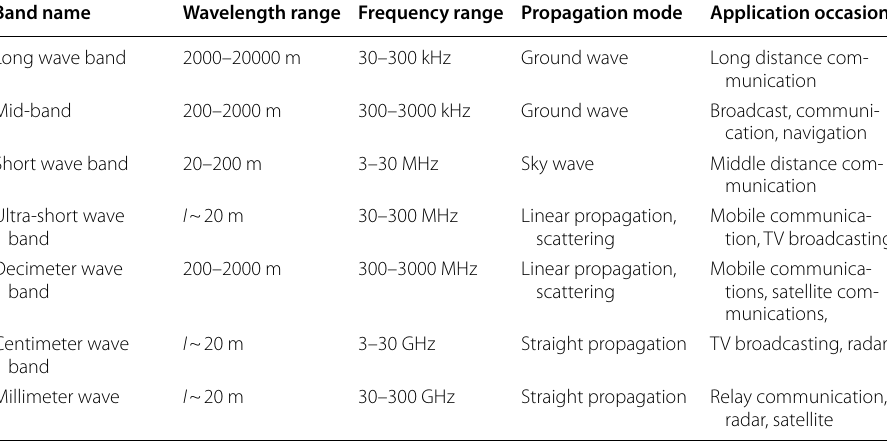
Table 1 Classification of wireless communication signals by